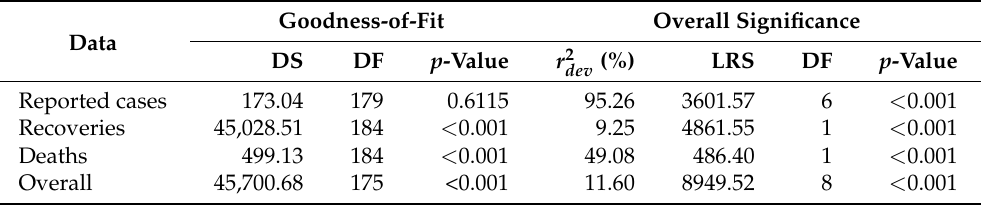
Table 4. Deviance based goodness-of-fit test results for the combination of an early exponential growth curve with a generic growth curve (fitted to daily PCR-confirmed positives) and logistic regression models (fitted to daily numbers of recoveries and deaths) using West African COVID-19 data from 28 February to 31 August 2020.